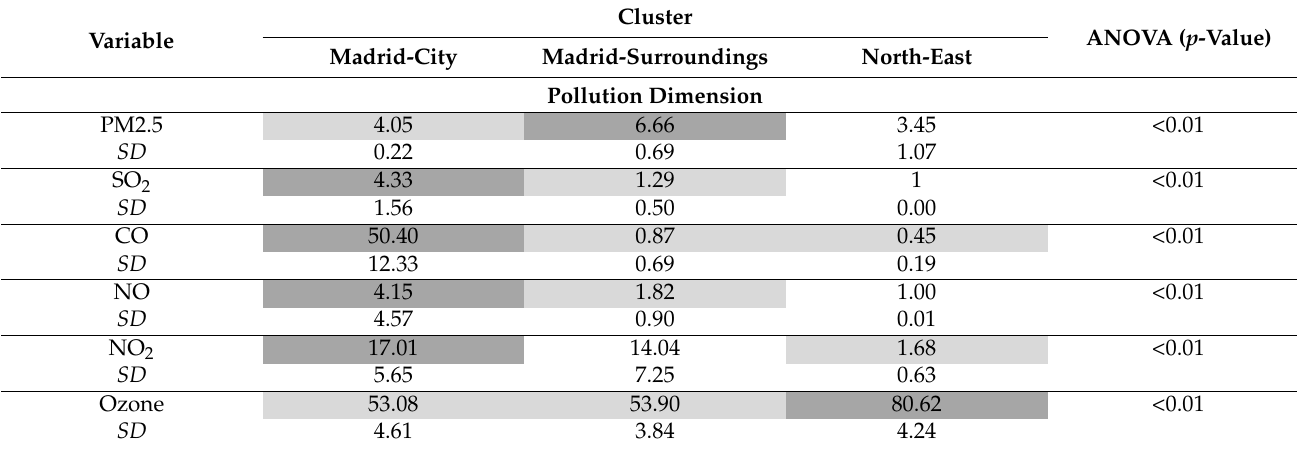
Table 3. Comparison of the mean values of the original variables by